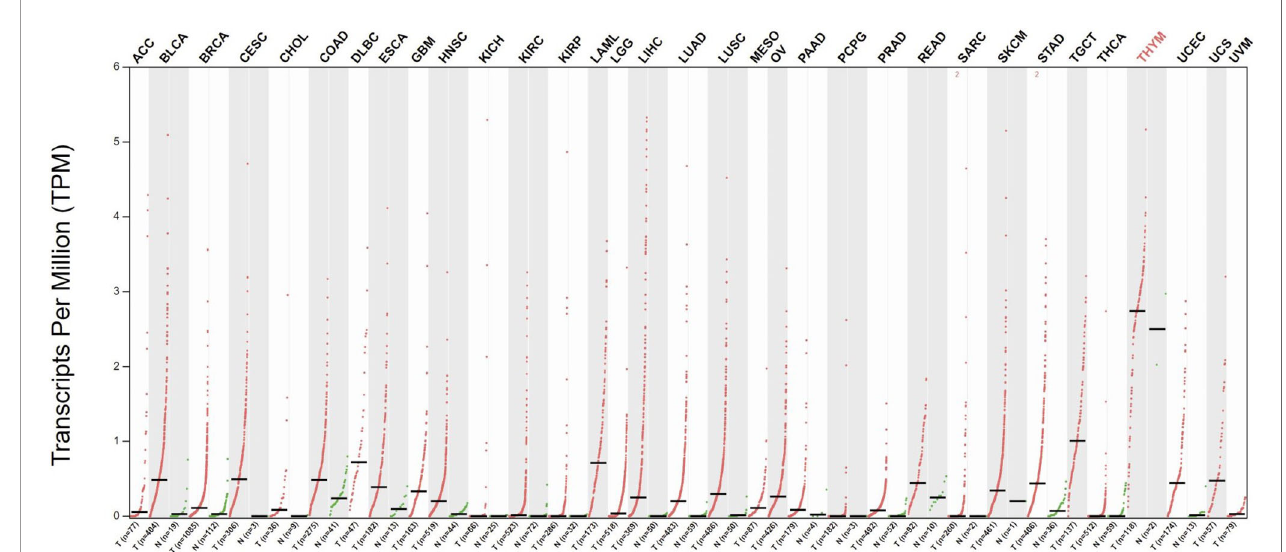
FIGURE 1 | Differential expression of hTERT in tumors vs. adjacent normal tissues. Red dots indicate primary tumor, and green adjacent healthy tissue. Data gathered from The Cancer Genome Atlas through GEPIA (32). Q-value cut-off was set to 0.01. ACC, Adrenocortical carcinoma; BLCA, Bladder Urothelial Carcinoma; BRCA, Breast invasive carcinoma; CESC, Cervical squamous cell carcinoma and endocervical adenocarcinoma; CHOL, Cholangiocarcinoma; COAD, Colon adenocarcinoma; DLBC, Lymphoid Neoplasm Diffuse Large B-cell Lymphoma; ESCA, Esophageal carcinoma; Glioblastoma multiforme GBM, Head and Neck squamous cell carcinoma HNSC, KICH, Kidney Chromophobe; KIRC, Kidney renal clear cell carcinoma; KIRP, Kidney renal papillary cell carcinoma; LAML, Acute Myeloid Leukemia; LGG, Brain Lower Grade Glioma; LIHC, Liver hepatocellular carcinoma; LUAD, Lung adenocarcinoma; LUSC, MESO, Lung squamous cell carcinoma; Mesothelioma; OV, Ovarian serous cystadenocarcinoma; PAAD, Pancreatic adenocarcinoma; PCPG, Pheochromocytoma and Paraganglioma; PRAD, Prostate adenocarcinoma; READ, Rectum adenocarcinoma; SARC, Sarcoma; SKCM, Skin Cutaneous Melanoma; STAD, Stomach adenocarcinoma; TGCT, Testicular Germ Cell Tumors; THCA, Thyroid carcinoma; THYM, Thymoma; UCEC, Uterine Corpus Endometrial Carcinoma; UCS, Uterine Carcinosarcoma; UVM, Uveal